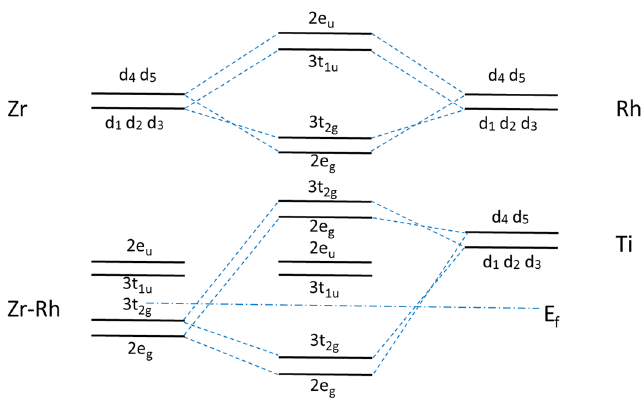
Figure 5. Schematic diagram of possible d-d hybridization between the transition-metal elements Zr-4d, Rh-4d, and Ti-3d in the ZrRhTiZ (Z = Al, Ga) compounds. The main group of elements Z (Z = Al, Ga) are not taken into account because the sp-bands are located at deep energy levels and barely contribute to the gap formation.